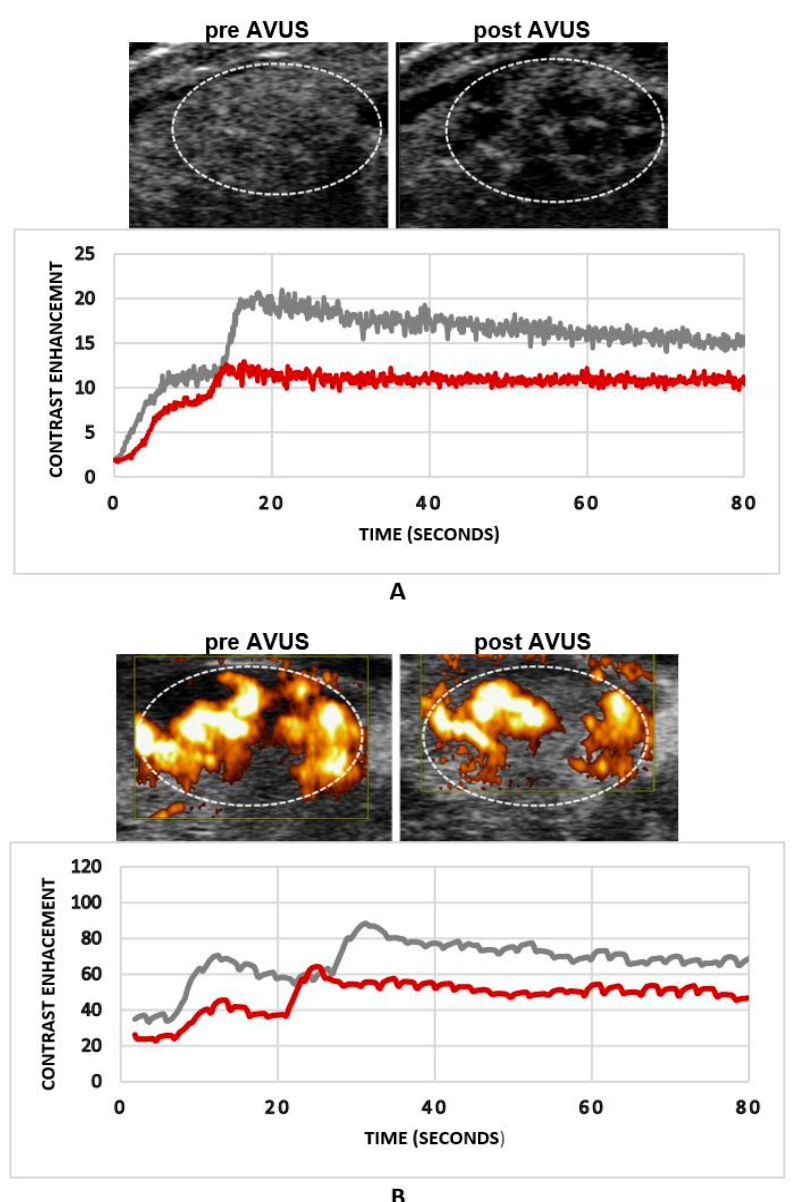
Figure 2. An example of an HCC tumor that received a single anti-vascular ultrasound therapy (AVUS) therapy. Panel ( A ) shows the reduction in tumor perfusion post therapy on nonlinear contrast (NLC) imaging. The tumor image post therapy shows multiple dark hypoechoic localized areas indicating lesser contrast coming after therapy. The dilution curve shows that tumor contrast enhancement was decreased more than 40% post therapy. Panel ( B ) shows the changes in tumor perfusion after therapy on power Doppler imaging. It is notable that the changes are more evident on NLC imaging compared to power Doppler (PD).